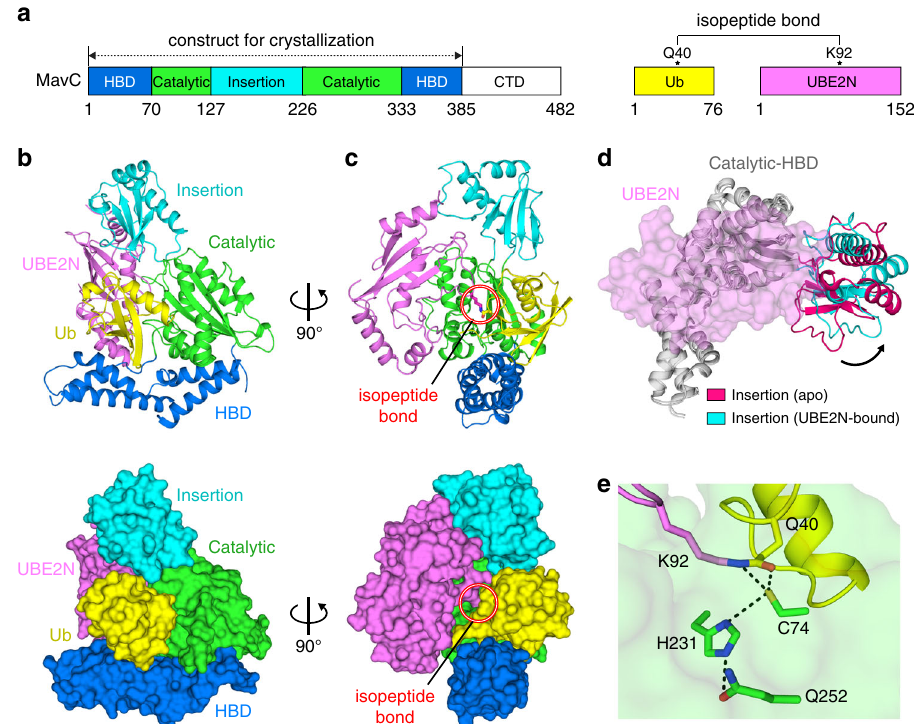
Fig. 1 Structure of MavC in complex with conjugated UBE2N~Ub. a Domain organization of MavC and conjugated UBE2N~Ub. b , c Two views of cartoon (upper) and surface (lower) representations of the MavC + UBE2N~Ub complex, with the same color code as in a . The isopeptide bond between UBE2N- K92 and Ub-Q40 was highlighted in red circles. d Structural superimposition of MavC in apo (PDB: 5TSC) and UBE2N-bound states and conformational changes of the Insertion domain upon binding to UBE2N. e Detailed hydrogen bonding interactions between MavC catalytic residues and the K92 – Q40